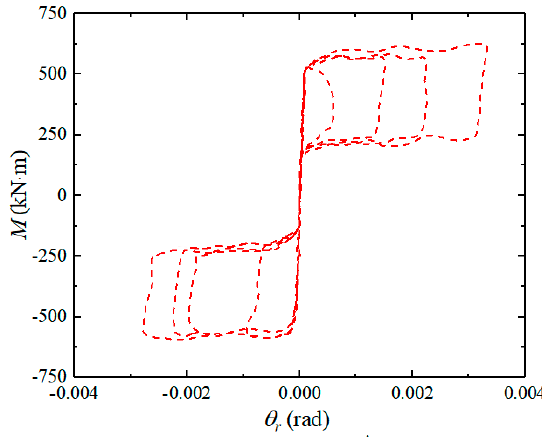
θ Figure 18. M - hysteretic relationships of the beam end joint for the new frame. Figure 18. M - θ r hysteretic relationships of the beam end joint for the new r